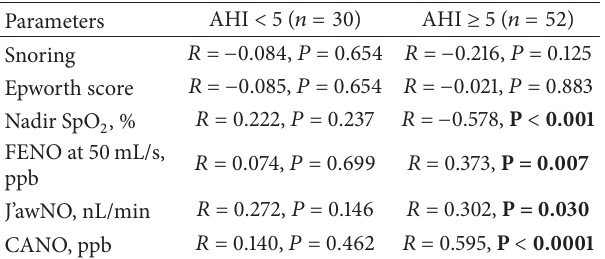
Table 2: Correlations between AHI and snoring, Epworth score, and exhaled NO.